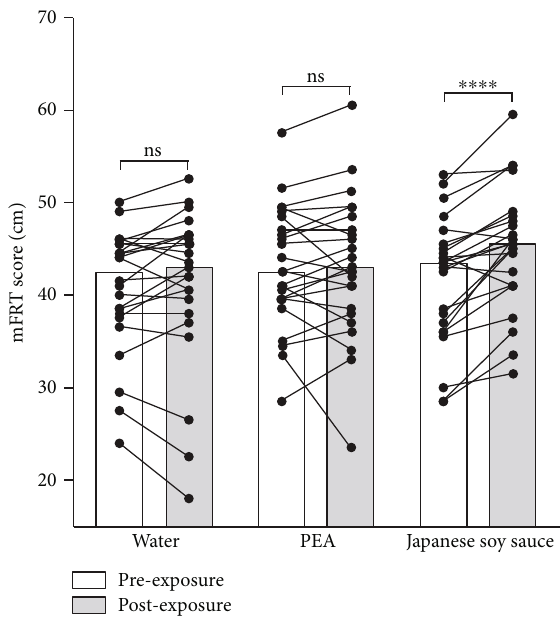
Figure 1: E ff ects of sni ffi ng water, PEA, or Japanese soy sauce on the mFRT score in healthy adults. Bar graphs indicate the median value of each group. ns: not signi fi cant. ∗∗∗∗ P < 0 : 0001